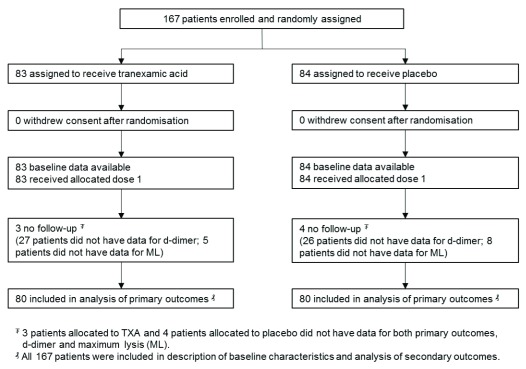
Consort diagram.